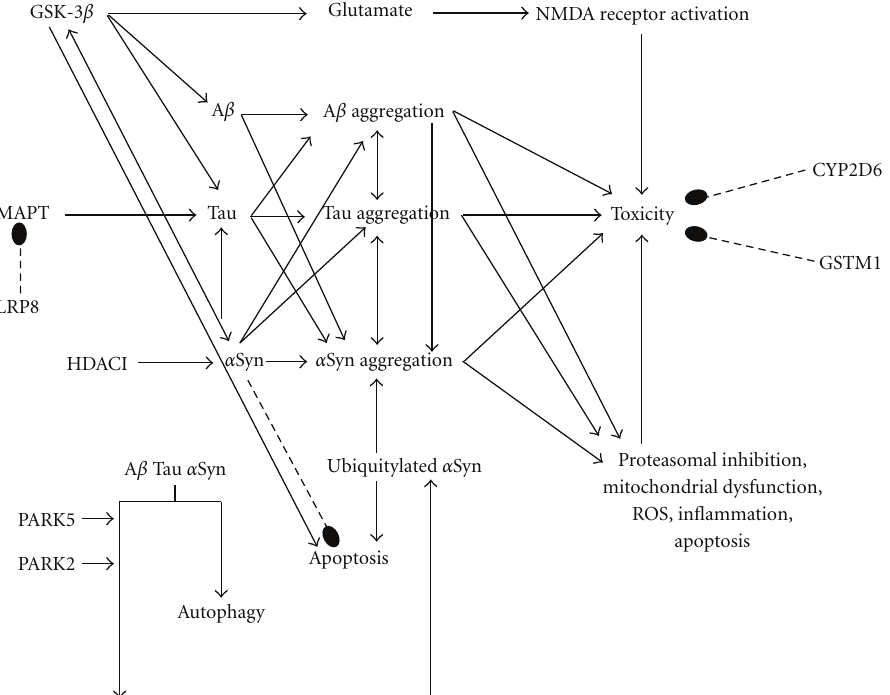
Figure 2: Interactions of neuroprotective and neurodegenerative pathways emphasizing pathogenic proteins and toxins. Relations ter- minating in an arrowhead indicate facilitation, those with double arrowheads indicate mutual facilitation, whereas dashed lines terminating in a bulb indicate inhibition. The enzyme glycogen synthase kinase 3 beta (GSK-3 β ) activates glutamatergic excitotoxicity mediated through the N-methyl-D-aspartate (NMDA) receptor. GSK-3 β also drives production of alpha-synuclein ( α Syn), the pathogenic proteins beta- amyloid (A β ) and tau, and apoptosis. Whereas α Syn appears to be neuroprotective and inhibits apoptosis, mono-ubiquitylated α Syn promotes α Syn aggregation and apoptosis. On the other hand, α Syn can also increase GSK-3 β and tau concentrations, in turn increasing aggregated α Syn, A β , and tau itself. Tau can further increase concentrations of α Syn. Aggregated α Syn, A β , and tau inhibit the proteasome and induce cellular toxicity, reactive oxygen species (ROS), mitochondrial dysfunction, apoptosis, and inflammation, leading to neuronal demise. The three proteins promote the formation of each other, as do their aggregated forms. The LRP8 gene product stabilizes microtubule associated protein tau (MAPT), the gene that produces tau protein, and dysfunctional LRP8 leads to excessive MAPT expression, increasing tau and driving pathogenic protein aggregation. Pathogenic proteins are disposed of through autophagy and the ubiquitin-proteasomal system, wherein proteins targeted for destruction are polyubiquitylated, a process that appears to be regulated by PARK5 (UCHL1) and PARK2 (parkin). Interference with autophagy or ubiquitylation prevents disposal of proteins, leading to their accumulation and their subsequent inhibition of the proteasome. GSTM1 and CYP2D6 gene products promote solvent detoxification, and deficiencies in these proteins permit toxicity. GSTM1 is particularly important in the context of CYP2D6